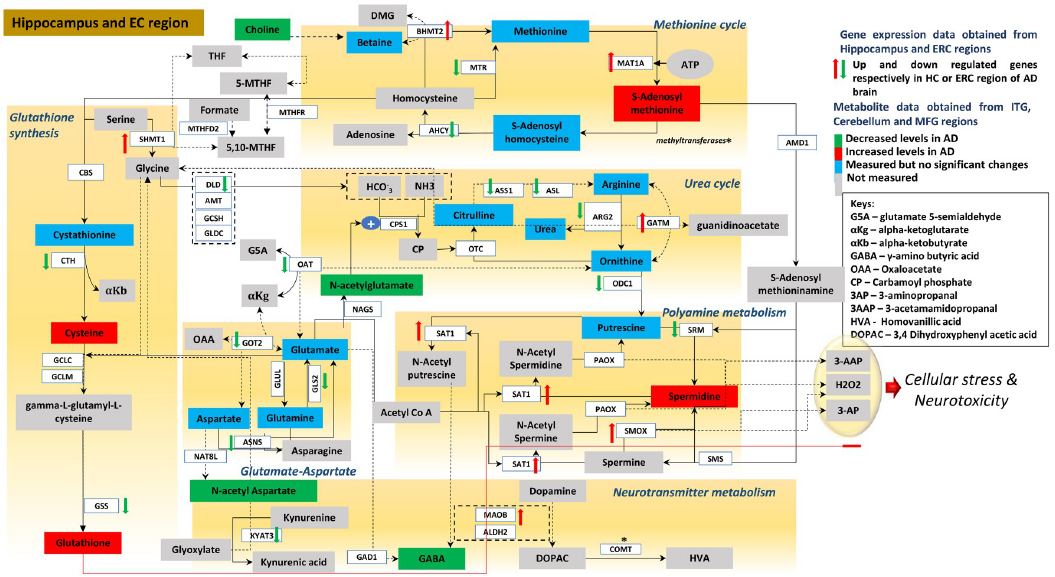
Fig 11. Integrated summary of alterations in metabolite concentrations and gene expression within metabolic pathways linked to transmethylation and polyamine synthesis/catabolism. Reactions within each of the six categories related to transmethylation and polyamine metabolism are shown within brown boxes [93–95].Metabolites whose concentrations are increased in the AD ITG relative to controls are shown in red boxes; those that are reduced in AD are shown in green boxes. Metabolites whose concentrations were measured but did not differ between AD and control are indicated in blue boxes; metabolites whose concentrations were not assayed are shown in gray boxes. Red up and green down arrows indicate significantly increased and reduced gene expression in the ERC/hippocampus, respectively. AD, Alzheimer disease; AHCY, adenosylhomocysteinase; ALDH2, aldehyde dehydrogenase 2; AMD1, adenosylmethionine decarboxylase 1; AMT, aminomethyltransferase; ARG2, arginase 2; ASL, argininosuccinate lyase; ASNS, asparagine synthetase; ASS1, argininosuccinate synthase 1; BHMT2, betaine homocysteine s- methyltransferase 2; CBS, cystathionine beta synthase; CN, Control; COMT, catechol-o-methyltransferase; CPS1, carbamoyl phosphate synthase 1; CTH, cystathionine gamma-lyase; DLD, dihydrolipoamide dehydrogenase; ERC, entorhinal cortex; GAD1, glutamate decarboxylase 1; GATM, glycine amidino transferase; GCLC, glutamate cysteine ligase catalytic; GCLM, glutamate cysteine ligase modifier; GCSH, glycine cleavage system protein H; GLDC, glycine decarboxylase; GLS2, glutaminase 2; GLUL, glutamine synthetase; GOT2, glutamic oxaloacetic transaminase 2; GSS, GSH synthetase; HC, hippocampus; ITG, inferior temporal gyrus; KYAT3, kynurenine aminotransferase 3; MAT1A, methionine adenosyltransferase 1A; MFG, middle frontal gyrus; MOAB, monoamine oxidase B; MTHFD2, methylenetetrahydrofolate dehydrogenase 2; MTHFR, methylenetetrahydrofolate reductase; MTR, methyltransferase; NAT8L, n-acetyltransferase 8 like; OAT, ornithine aminotransferase; ODC1, ornithine decarboxylase 1; OTC, ornithine carbamoyltransferase; PAOX, polyamine oxidase; SAT1, spermidine/spermine n1-acetyltransferase 1; SHMT1, serine hydroxymethyl transferase 1; SMOX, spermine oxidase; SMS, spermine synthase; SRM, spermidine synthase.